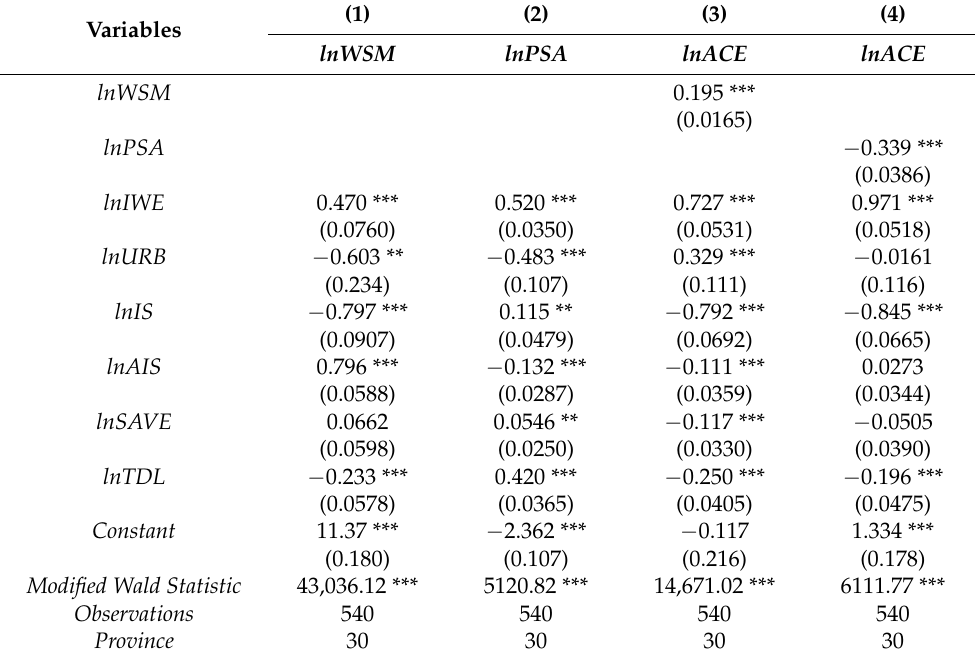
Table 7. Results of the mechanism